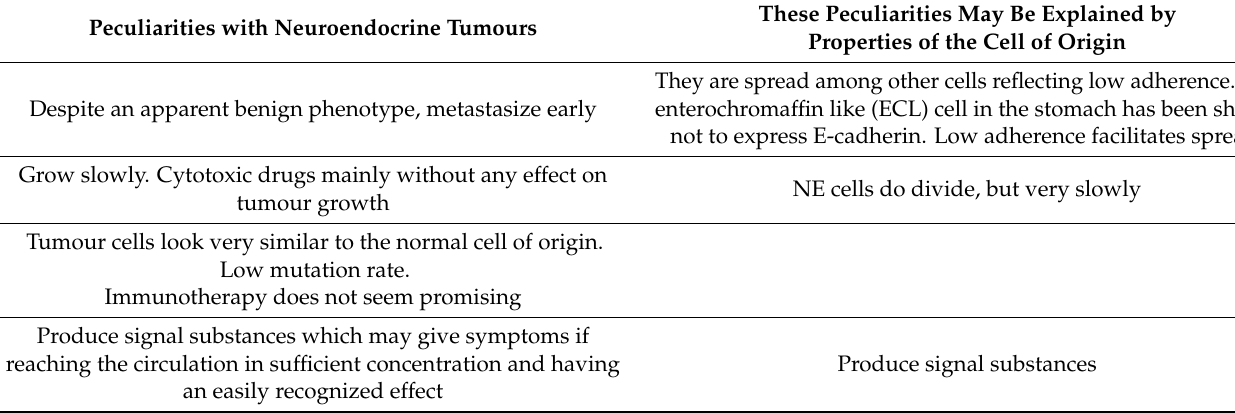
Table 1. The traits of the neuroendocrine tumours reflect closely the properties of the normal neuroendocrine cells which in many respects are predisposed to tumour